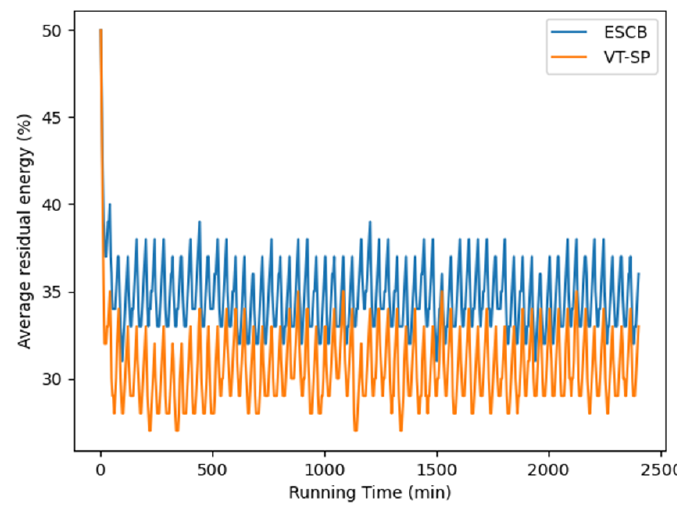
Figure 14. Average residual energy.